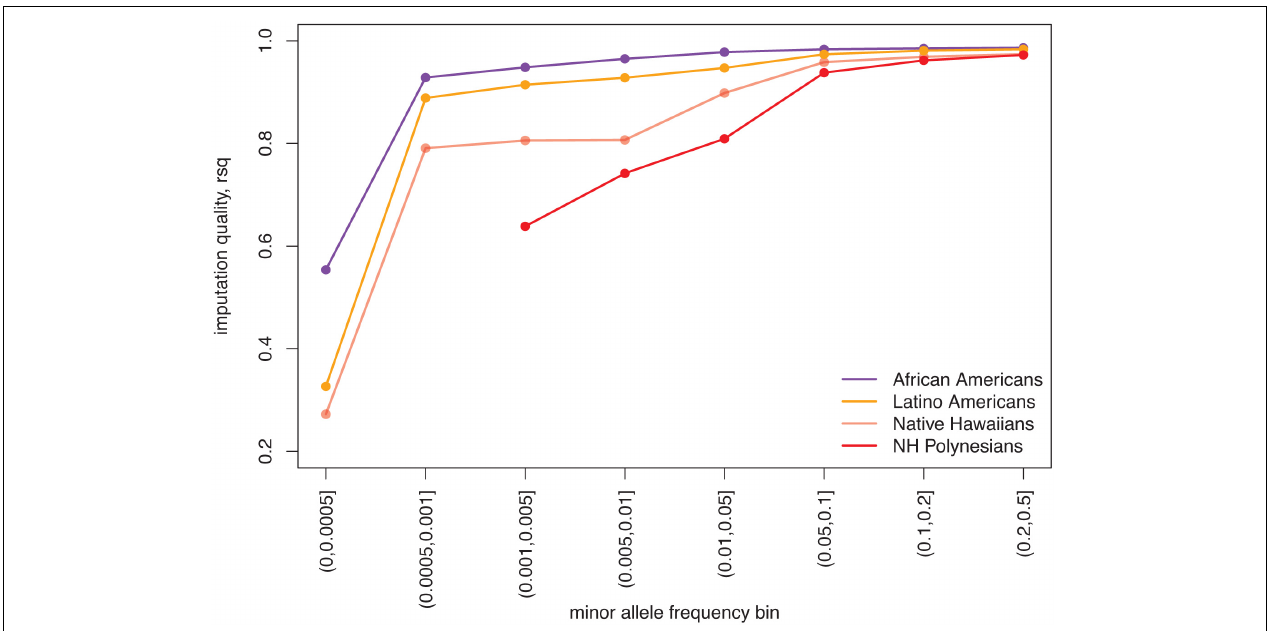
FIGURE 2 | Relatively poor imputation quality for Native Hawaiians due to underrepresentation in imputation reference panels. We imputed 5,325 African Americans, 2,838 Latino Americans, and 3,940 Native Hawaiians from the Multiethnic Cohort (Kolonel et al., 2000) using freeze 8 of the TOPMED imputation server (Taliun et al., 2021) (imputed in July 2020). Each population was genotyped on the MEGA array and subjected to the same QC filters. As measured by the mean imputation quality, R 2 (rsq), Native Hawaiian individuals are imputed more poorly than other United States ethnic minority populations, particularly for variants with minor allele frequency < 5%. The disparity is even stronger when focusing on only the 178 Native Hawaiians with estimated Polynesian ancestry > 90% (NH Polynesians) (Lin et al.,